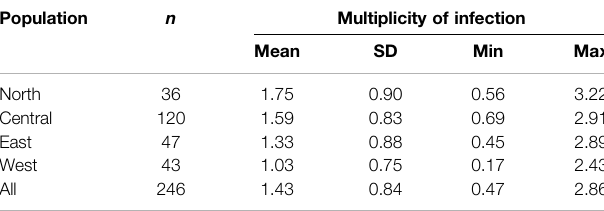
TABLE 5 | Multiplicity of infection in Sudanese Theileria annulata